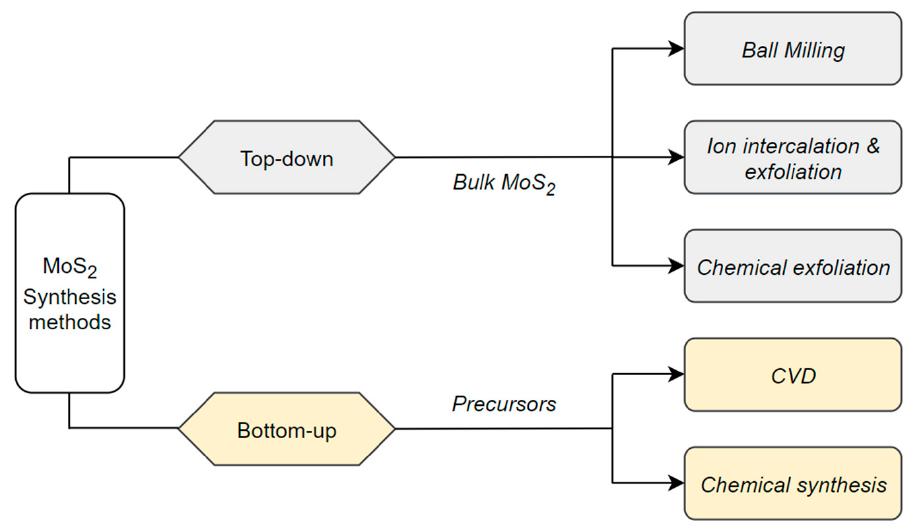
Figure 2. MoS 2 synthesis pathways.